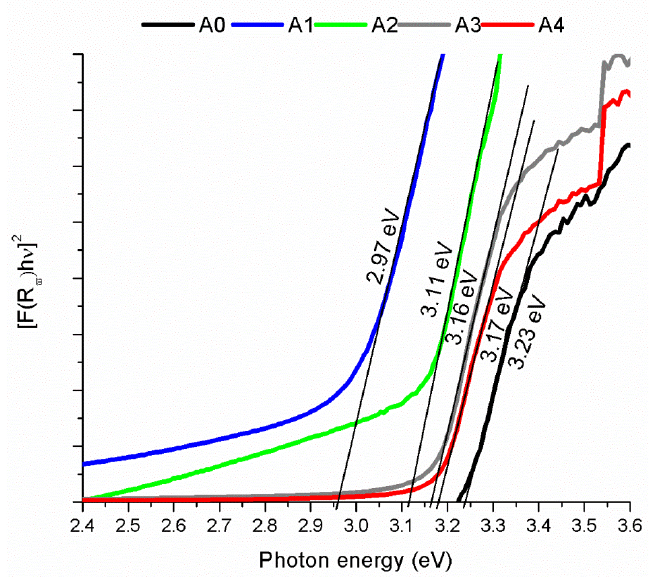
Figure 6. UV-DRS. The Kubelka–Munk approximation was used to estimate the Eg. A0 is the refer- ence sample deposited without Ni at 500 °C. The samples A1, A2, A3, and A4 were deposited with reference sample deposited without Ni at 500 ◦ C. The samples A1, A2, A3, and A4 were deposited ZnO:Ni at 500 °C, 400 °C, 350 °C, and 300 °C, respectively. The change of the band gap Eg is at- with ZnO:Ni at 500 ◦ C, 400 ◦ C, 350 ◦ C, and 300 ◦ C, respectively. The change of the band gap Eg is tributed to the incorporation of the Ni in correlation with the deposit temperature. attributed to the incorporation of the Ni in correlation with the deposit